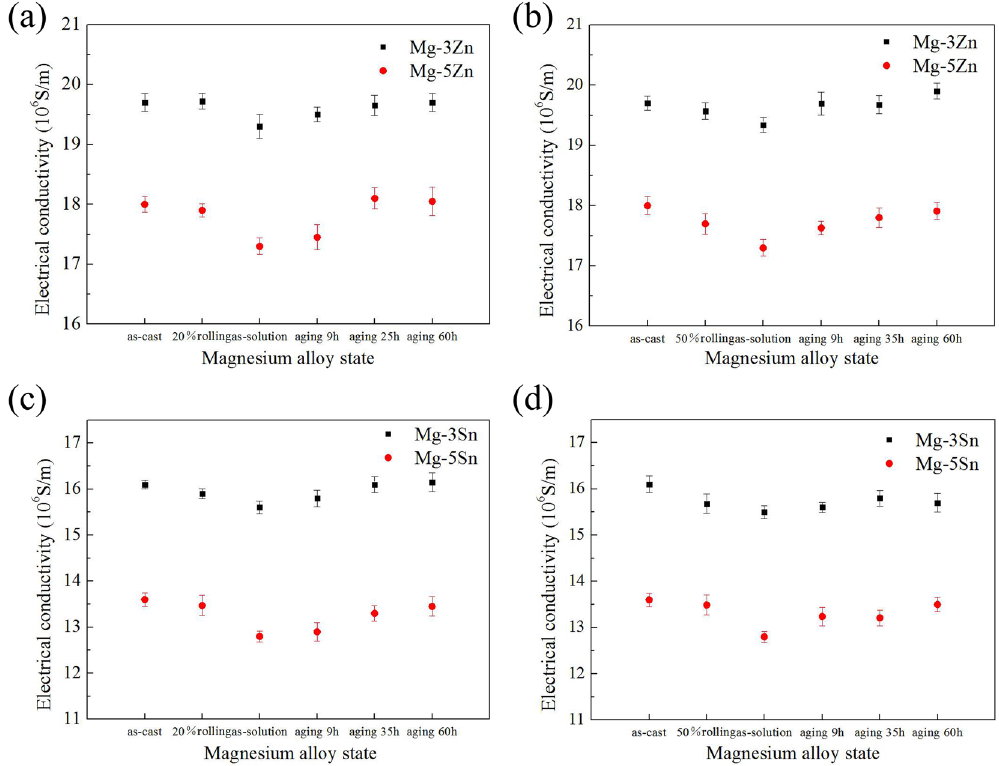
Figure 11. Electrical conductivity of the alloys in different states: ( a , c ) 20% rolled and ( b , d ) 50%